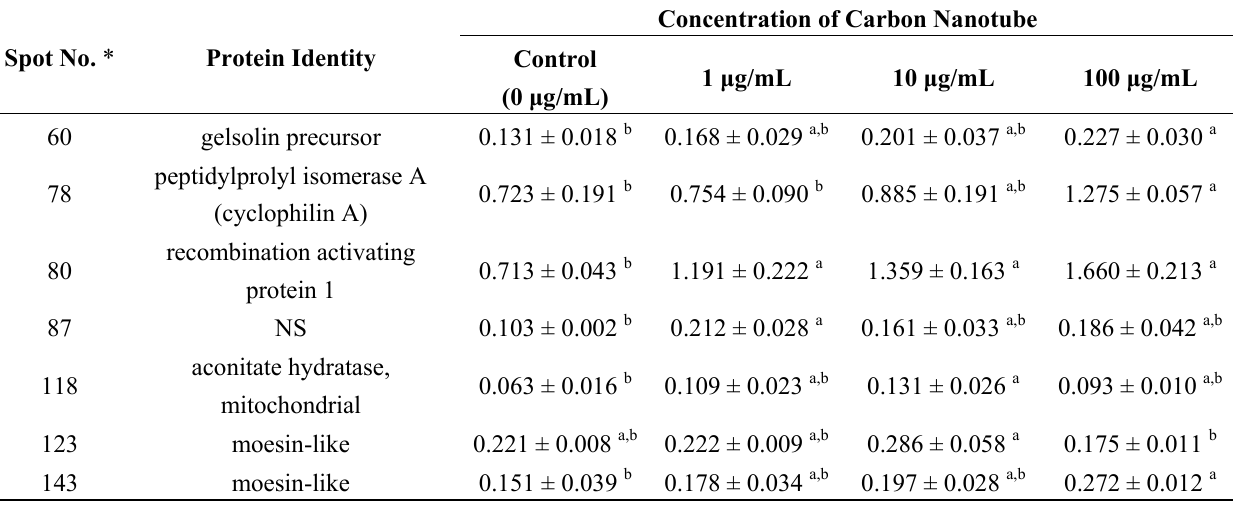
2. Differentially expressed protein spots in carbon nanotube-treated chicken heterophils.